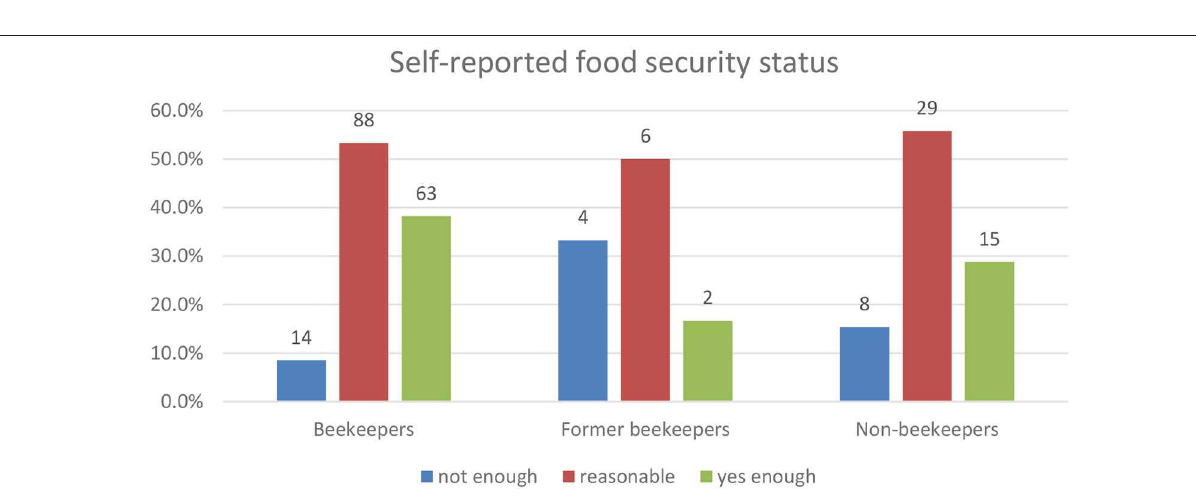
Frontiers in Forests and Global Change |